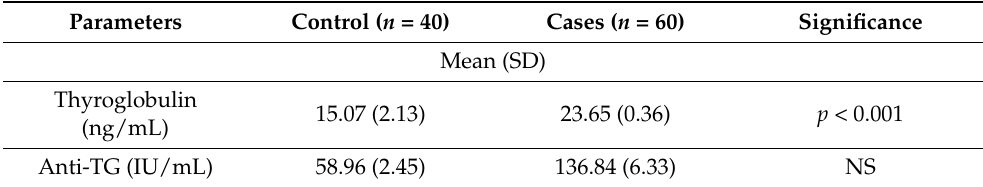
Figure 2. ( A ) 131 I whole-body scan. The study was performed 5 days post oral administration of 60 mCi, 131 I therapy dose showing Manuel tracer uptake in the neck at the thyroid bed region with no abnormal tracer accumulation in the rest of the body. ( B ) 131 I whole-body scan. The study was performed 48 h post oral administration of 5 mCi, 131 I showing no active thyroid tissues, either in the neck or in the rest of the body (negative study). Table 2. Comparison of the levels of Tg and anti-TG among cases and controls.